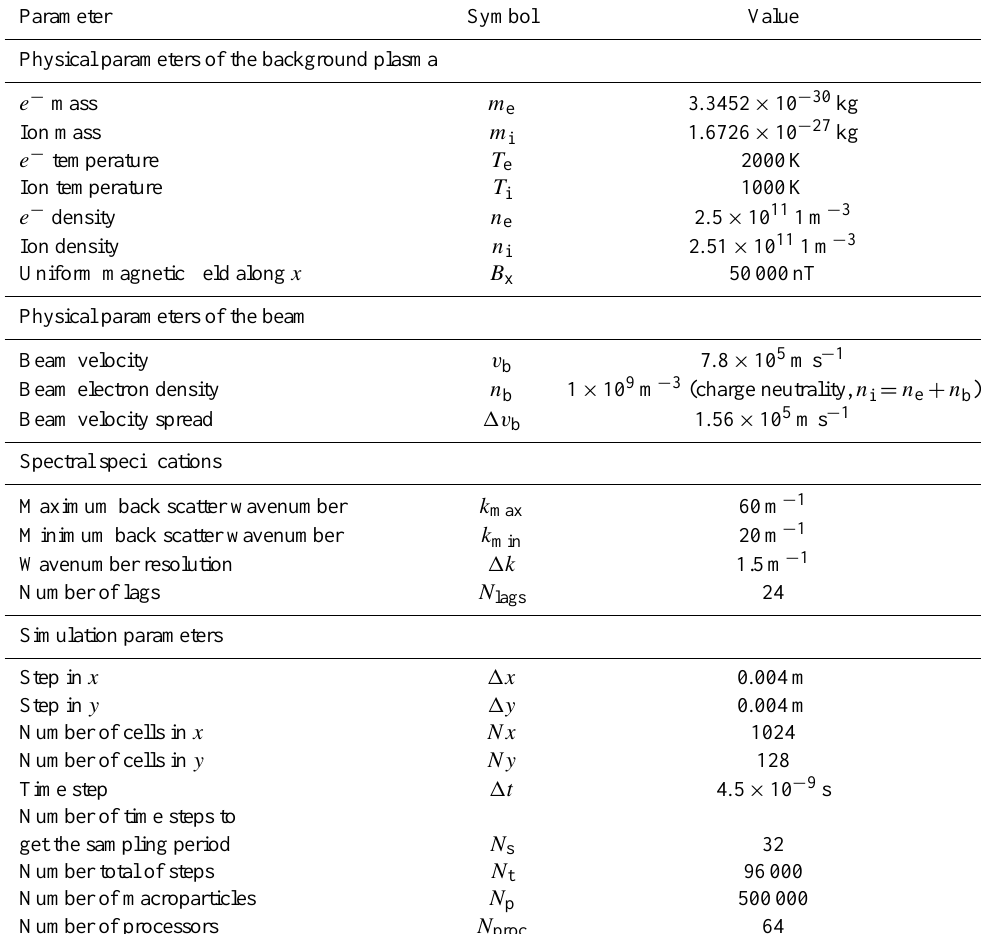
Table 1. Summary of the parameters used to simulate the decay of Langmuir waves.